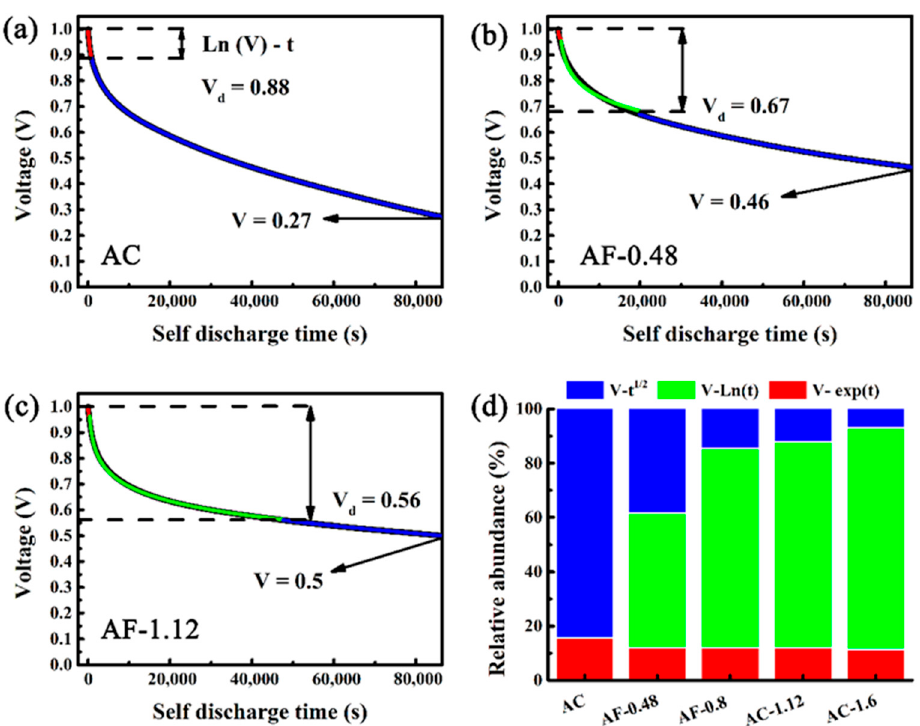
Figure 5. Simulated self-discharge (SDC) of AC and Fe@C composite electrodes by multiple processes: ( a ) AC electrode, ( b ) AF-0.48 electrode, and ( c ) AF-1.12 electrode. The control time of different self-discharging processes ( d ).